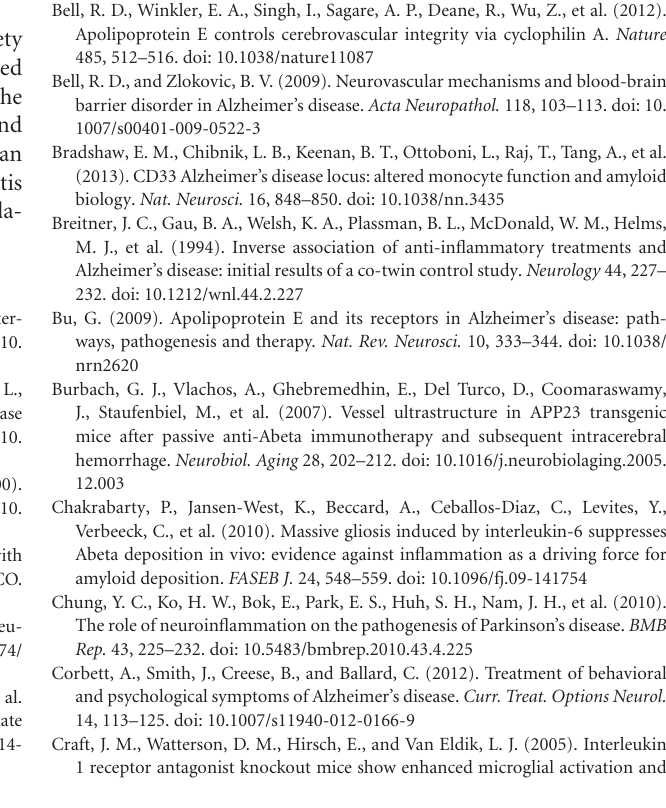
FIGURE 1 | Neuropathological features, inflammation, and cognitive/non-cognitive symptoms of Alzheimer disease . Cerebral accumulation of amyloid plaques and neurofibrillary tangles (NFT) leads to neurodegeneration in the AD brain, which causes progressive cognitive dysfunction such as memory loss and language problems. Non-cognitive